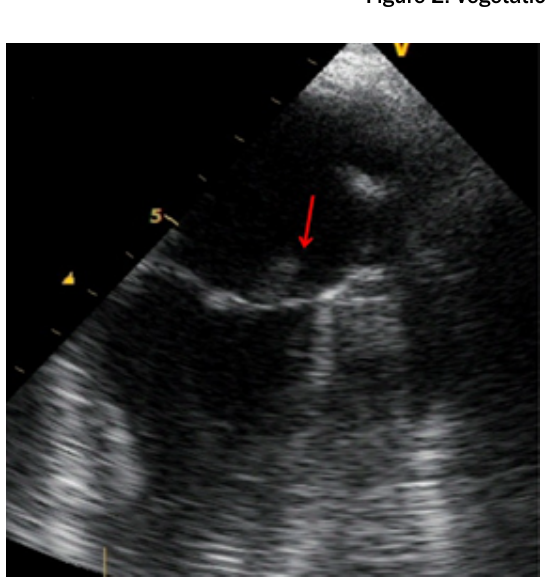
Figure 3: Vegetation on posterior mitral valve (control)